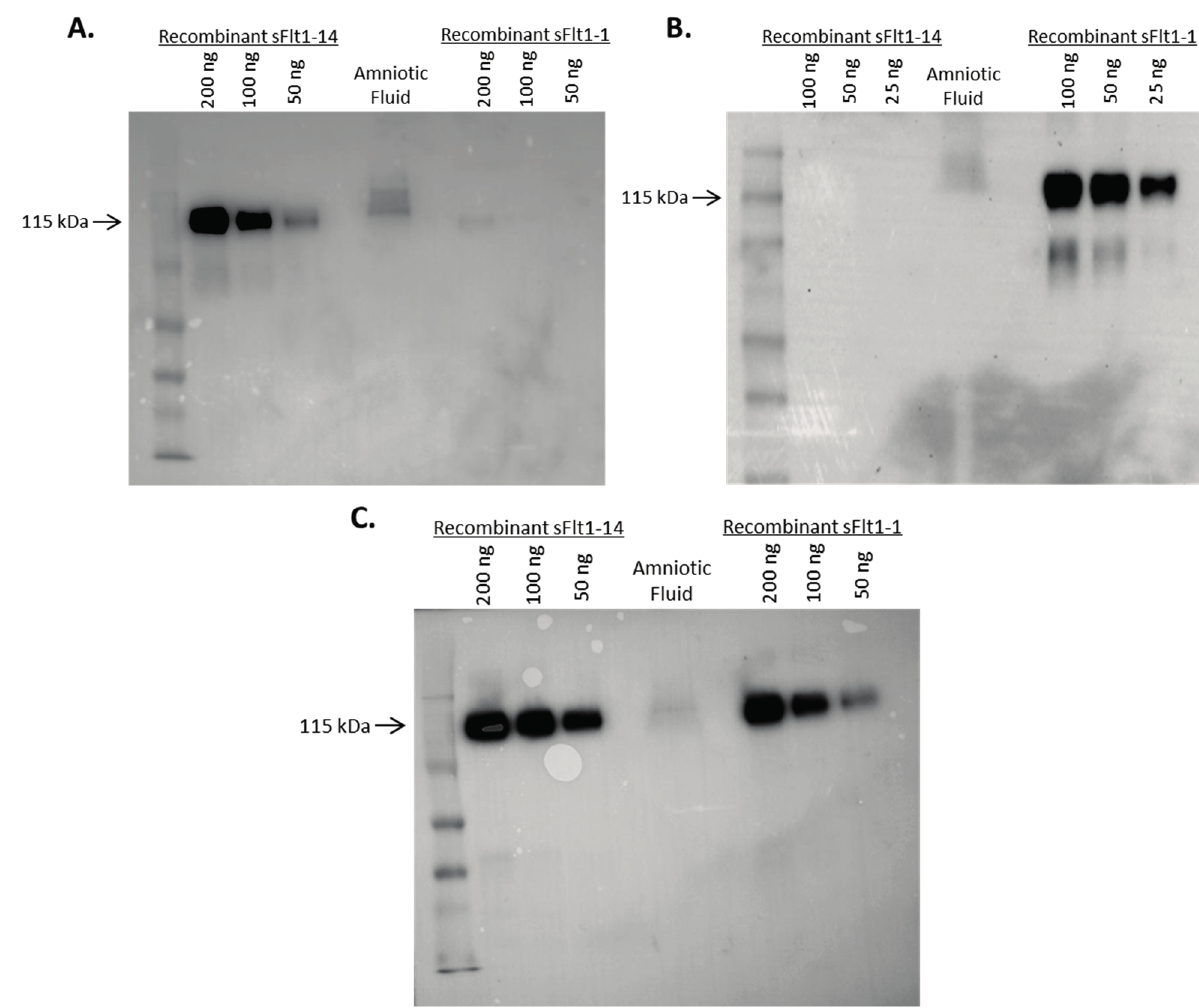
Figure 4. Mouse mAbs Ex14-1 ( A ) and 1CKLH18 ( B ) specifically detected endogenous sFlt1 isoforms from amniotic fluid on a Western blot. Each mAb recognized a single protein of the expected molecular weight (~115 kDa) when compared to recombinant standards. Included as a positive control ( C ) is a commercially available mAb (Sigma Cat.#V4262) that recognized total